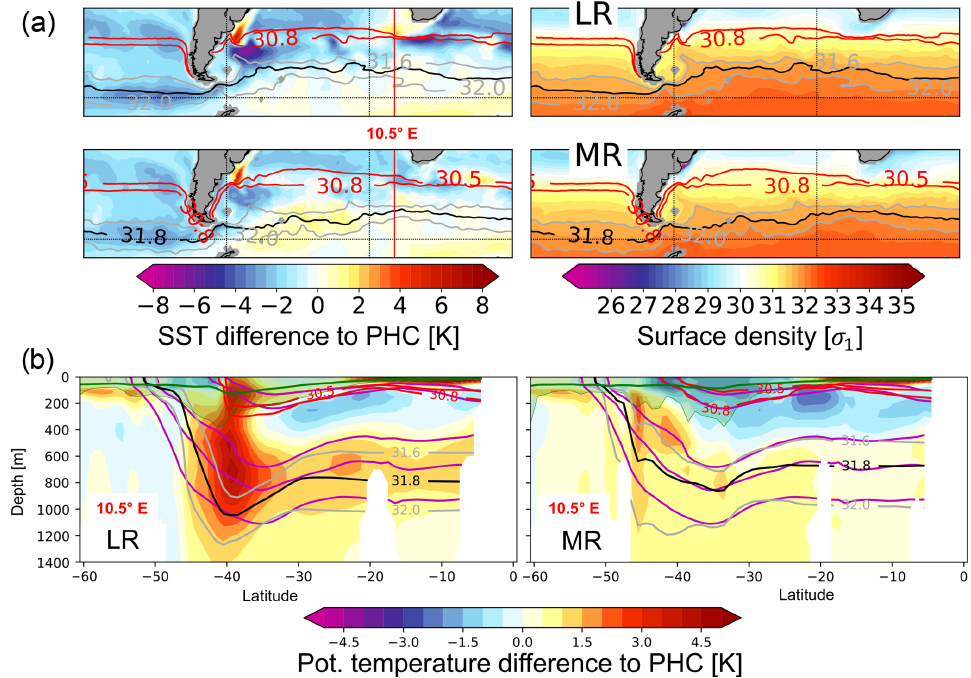
Figure 11. (a) Right: the Southern Ocean σ 1 –density structure at the ocean surface in LR and MR (years 71–100). Black and gray contours indicate outcropping areas for typical isopycnal surfaces found in the deep ocean around 1000m; red contours represent shallower isopycnal surfaces with a maximum depth of about 200m. Left: sea surface temperature (SST) biases in the two simulations (years 71–100) with respect to PHC. Simulated σ 1 –density contours are overlaid (identical to the contour levels in the right panels). A meridional section at 10.5 ◦ E is highlighted with a vertical red line. (b) Meridional section at 10.5 ◦ E, to the west of Cape Agulhas, showing the potential temperature bias with respect to PHC in (left) LR and (right) MR (years 71–100). Contours show simulated σ 1 –density contours that are representative for the deep ocean between ≈ 600 and 1000m (gray and black; 31.6, 31.8, 32.0) and for the surface ocean until a maximum depth of about 200m (red; 30.5, 30.8). In contrast to LR, the tilt of the isopycnals in MR is a close fit to the “target” σ 1 contours from PHC (given in magenta). The average (maximum) mixed layer depth in the 30-year window is overlaid with a green line (green shading).